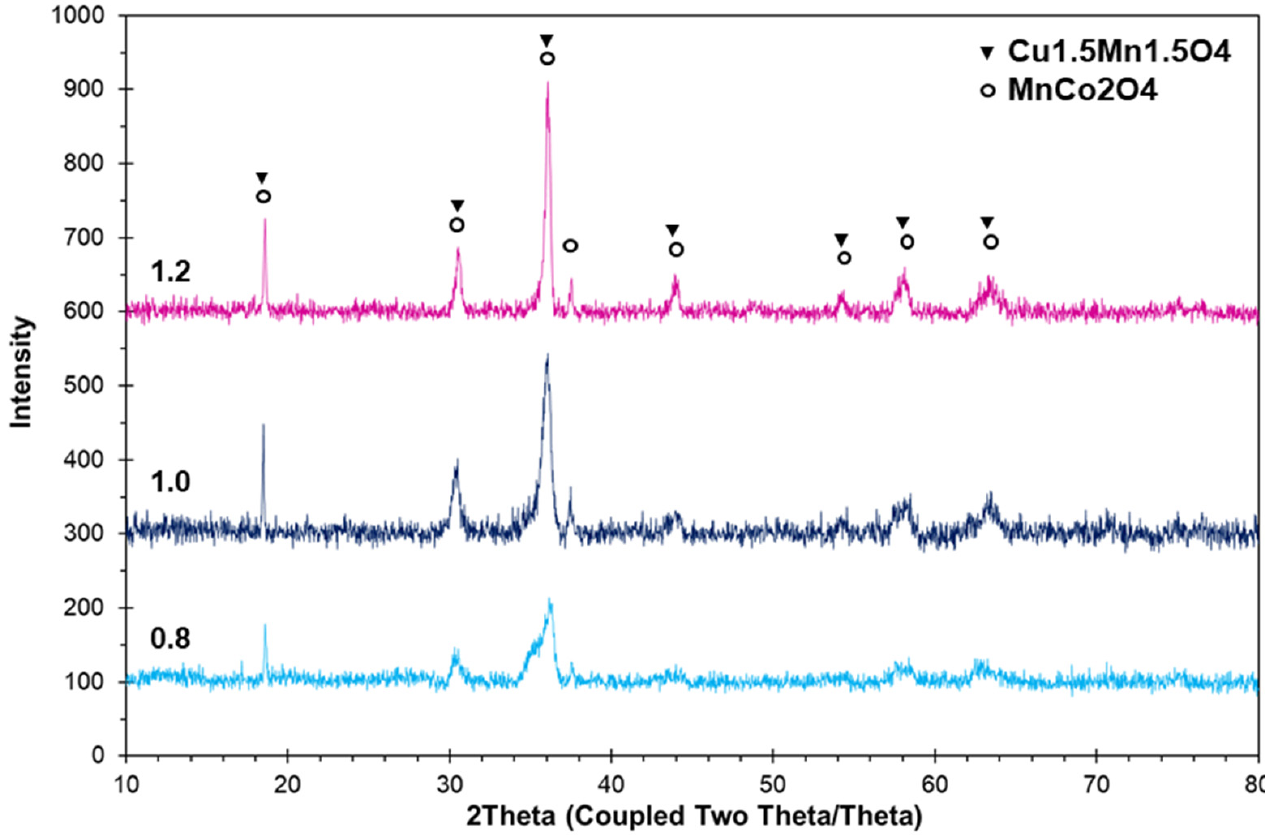
Figure 6. X-ray diffraction patterns for the pelletized CMC spinel sintered at 1200 °C. Table 2. Degree of crystallinity, percentage of each constituent phase of and grain size of the pelletized CMC spinel sintered at 1200 °C.